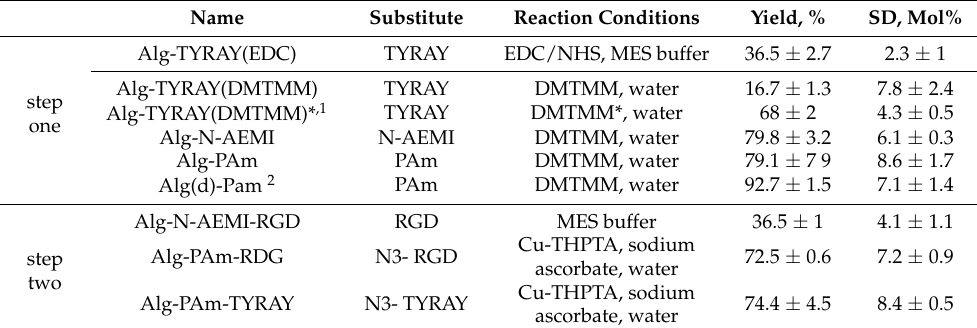
Table 2. Reaction conditions, yields, and substitution degree of the modification for all used methods. The molar ratio between alginate and substitutes was kept at 1 to 0.01 for all the experiments. All values are reported as mean with the standard deviation ( n = 3).